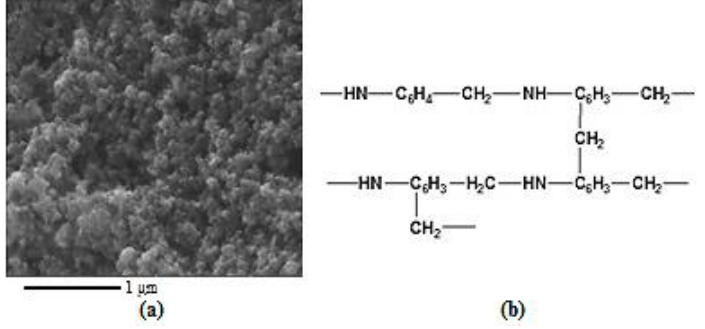
Figure 1. ( a ) SEM image of the AF polymer heat treated at 200 °C; ( b ) its proposed